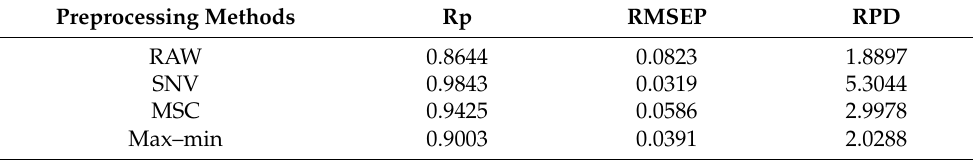
Table 1. Result of moisture content prediction model for different preprocessing methods.